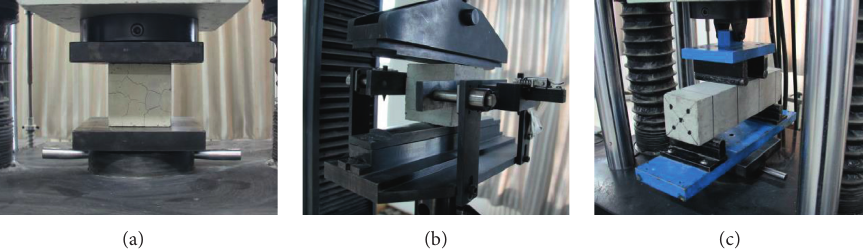
Figure 6: Loading diagram of DSC. (a) Uniaxial compressive test. (b) Splitting tensile strength test. (c) Flexural strength test.